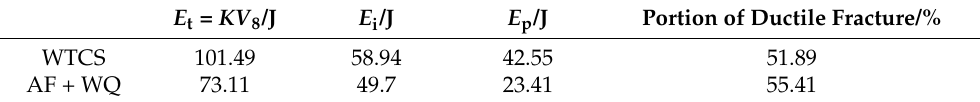
Figure 7. F-t and E-t diagrams of the instrumented Charpy tests and SE-SEM images of the fracture surfaces: ( a , b ) WTCS specimens; ( c , d ): AF + WQ specimens. Table 5. Results of the instrumented Charpy tests for both types of simulated FG HAZ specimens.